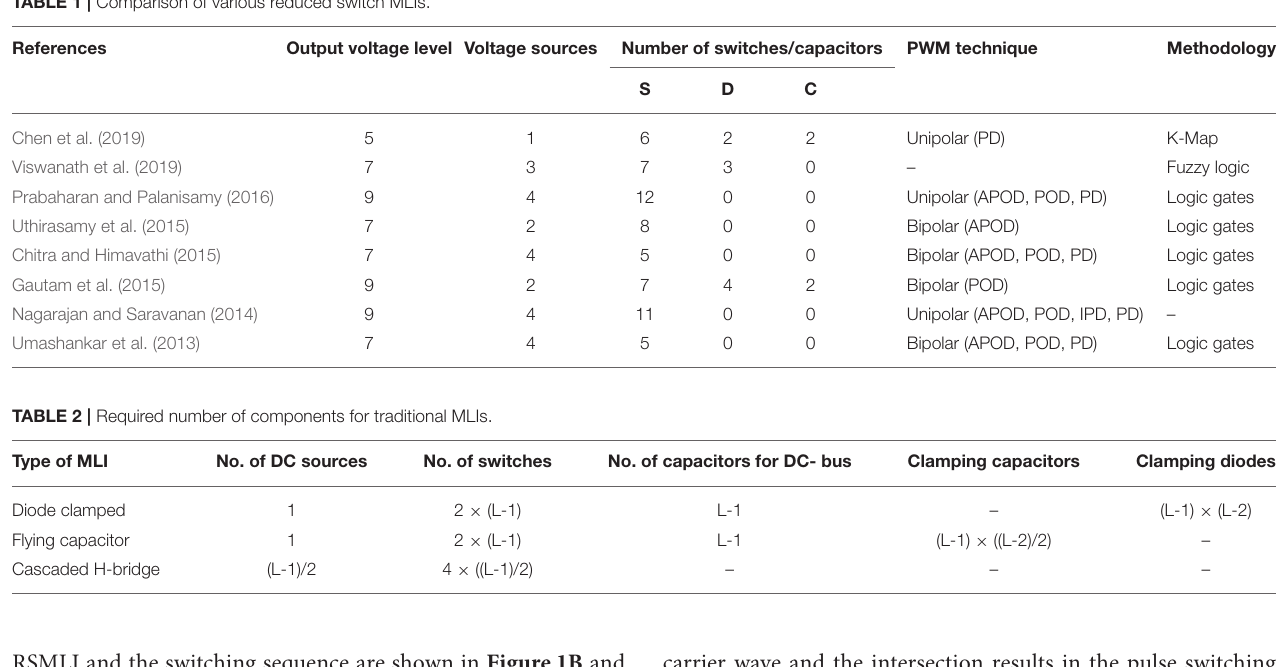
TABLE 1 | Comparison of various reduced switch MLIs.